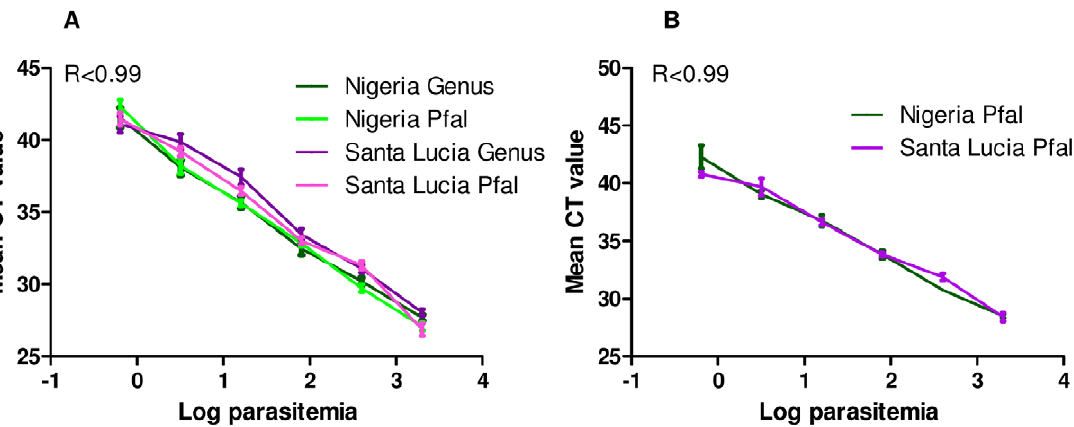
Figure 2. Quantitative comparison of PET-PCR assay and Rougemont real-time PCR assay. The PET-PCR and Rougemont real-time PCR assays were run using two well-quantified P. falciparum strains (Nigeria and Santa Lucia) used at six differing parasitemia levels (2000, 400, 80, 16, 3.2 and 0.64 parasites/ m l). To determine the correlation between CT values and parasitemia, the mean CT values obtained in the PET-PCR assay (A) and in the Rougemont real time PCR assay (B) were plotted against the log transformed parasitemia (Log parasitemia). The CT values demonstrated reproducible linearity over the parasitemia range tested as both methods show significant correlation with R 2 values . 0.990. No statistical difference in mean CT values was observed for the two different strains or for the two different methods (P . 0.05).